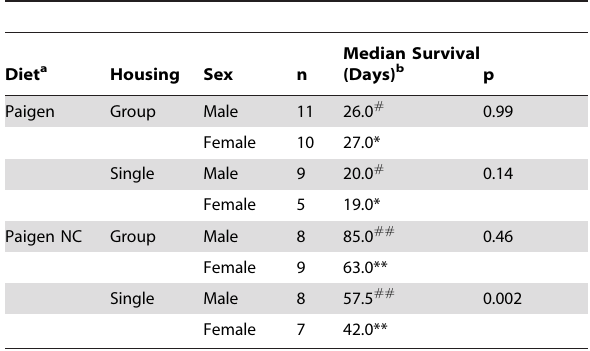
Table 2. Effects of Atherogenic Diets, Population Density and Sex on